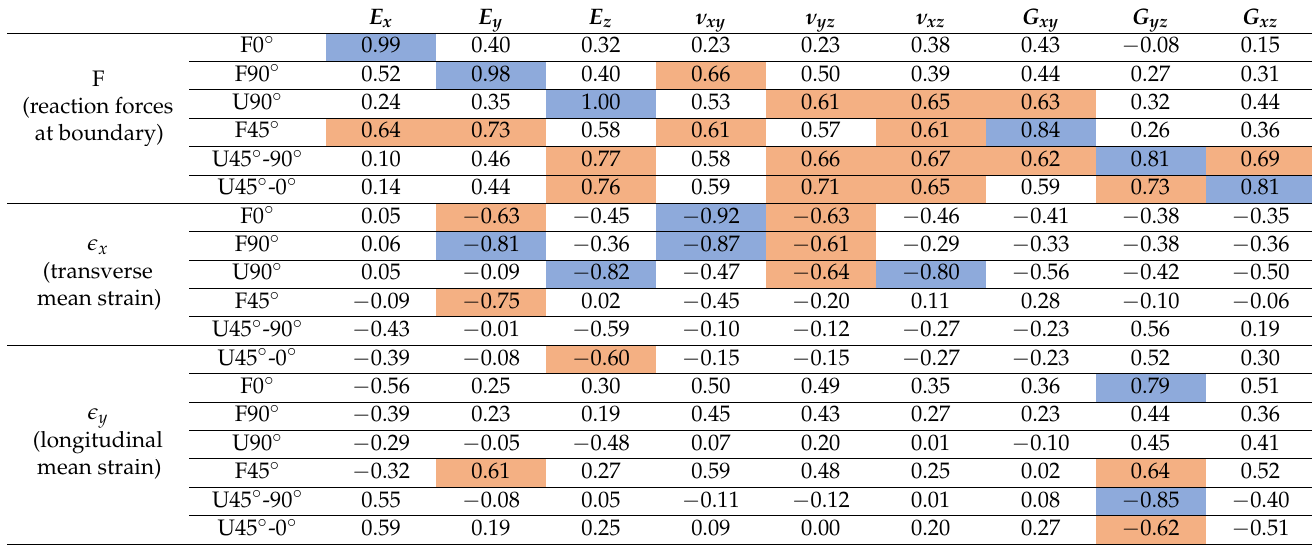
Table 4. Linear correlation coefficients between input and output parameters. Blue: Correlation